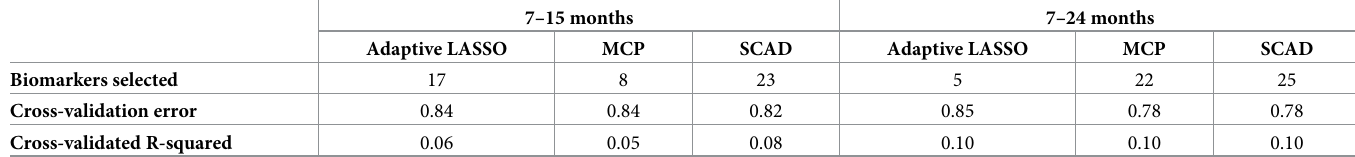
Table 2. Number of biomarkers selected (assigned non-zero coefficients) and cross-validation error for three penalized regression models fitted on two biomarker